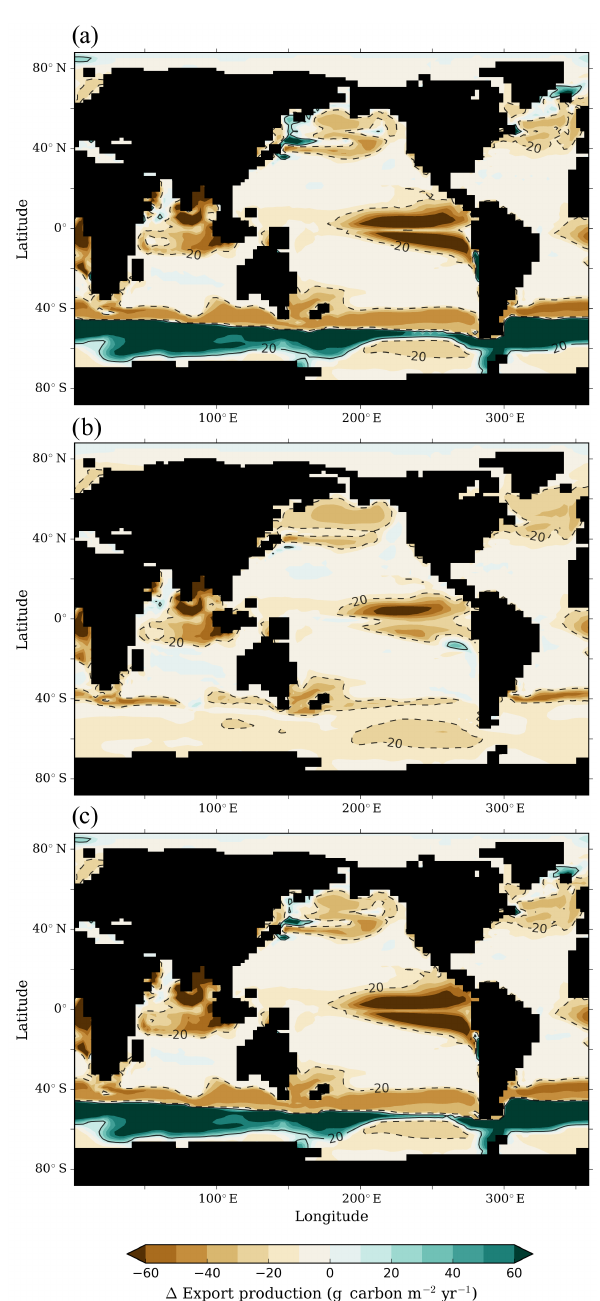
Figure 10. Change in annually averaged export of particulate or- ganic carbon from the upper 50m (gCm − 2 year − 1 ) between the LGM and PI from the experiments with modified biogeochemi- cal formulations for (a) O-LGM BGC poc − O-PI, (b) O-LGM BGC rem − O- − O-PI. It should be noted that the export PI and (c) O-LGM BGC all production field of particulate organic carbon for experiment O- LGM BGC , whereby particulate inorganic carbon was set to zero, pic did not differ from unmodified experiment O-LGM and is therefore not shown. For this comparison, the reader is directed to Fig.